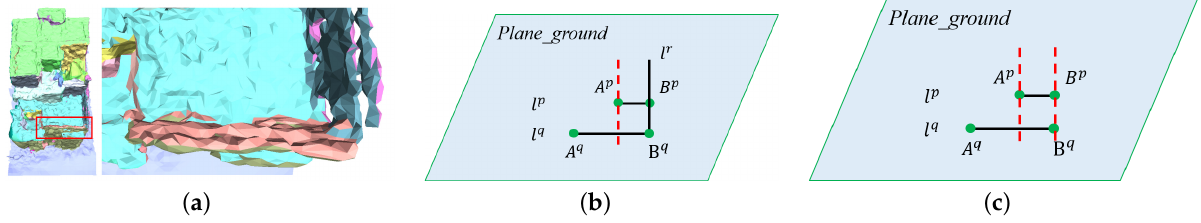
Figure 6. Two-dimensional projection of a thin-plate structure with increasing facade cases: ( a ) Thin- plate segmentation, ( b ) Adding one plane, and ( c ) Adding two planes.